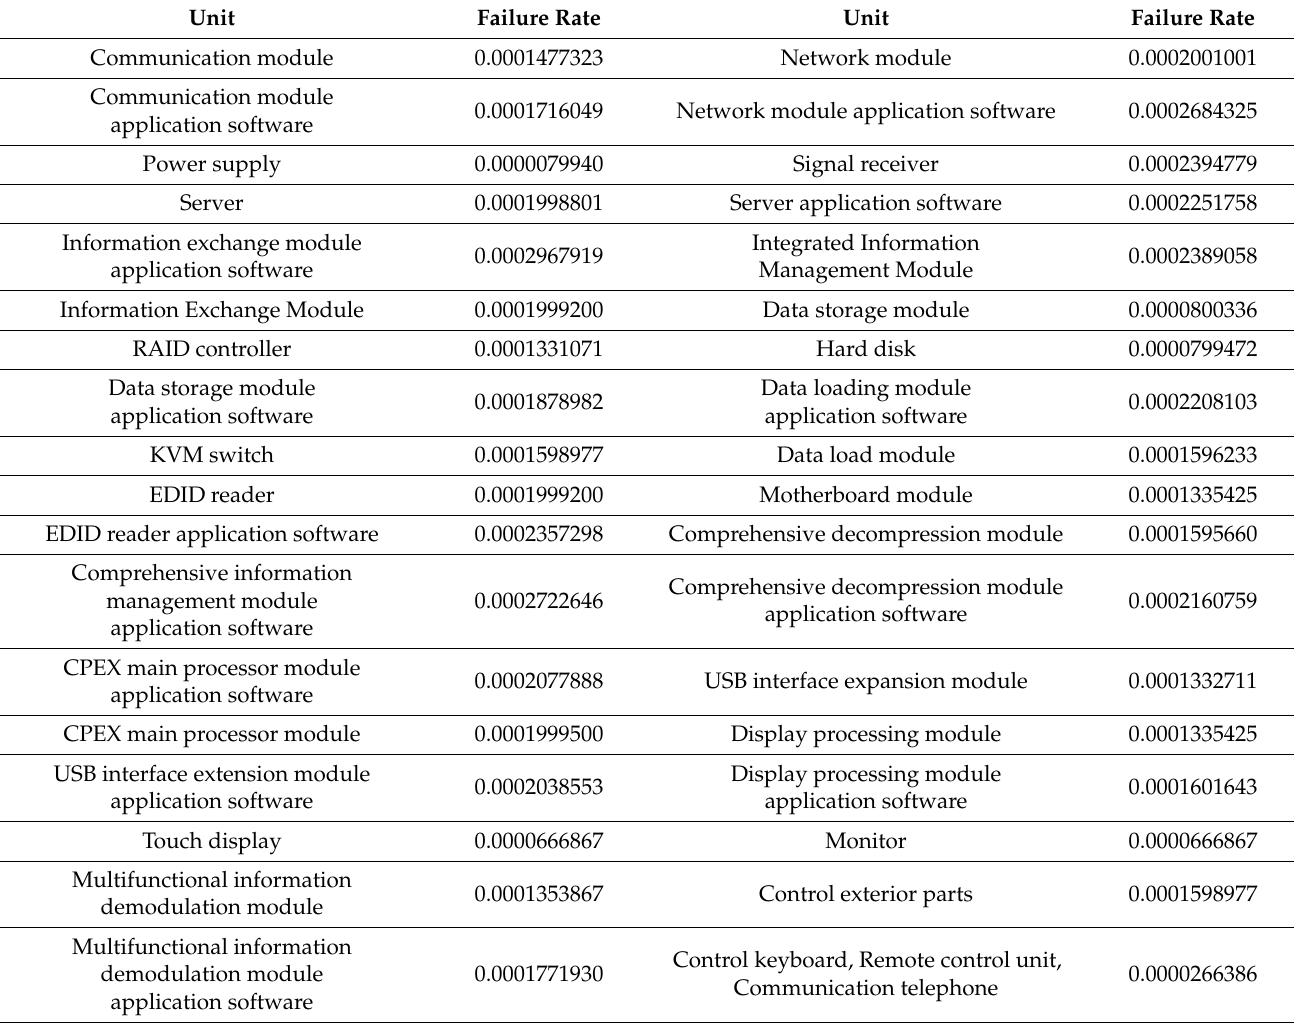
Table 3. Failure rates of the C 4 ISR system